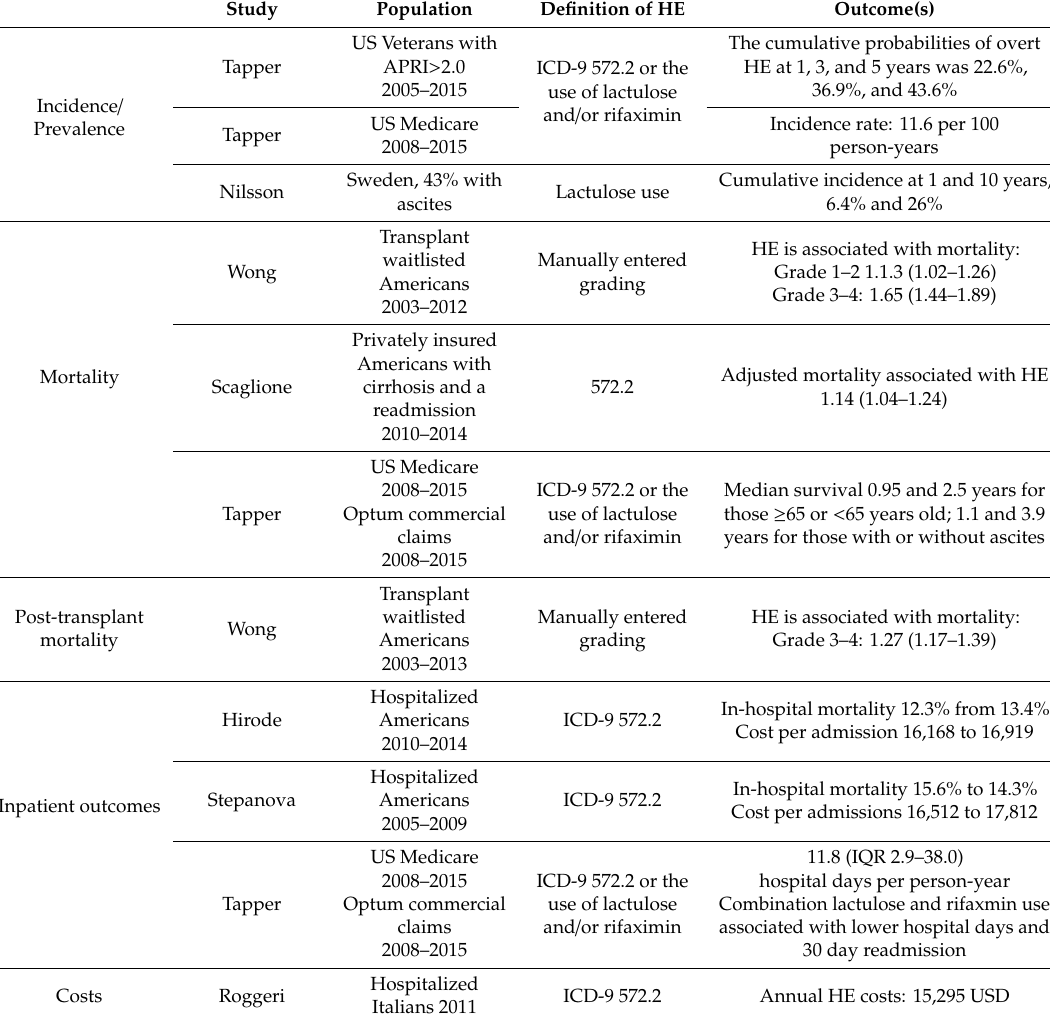
Table 3. Administrative Studies Detailing the Outcomes Associated with Hepatic Encephalopathy (HE).